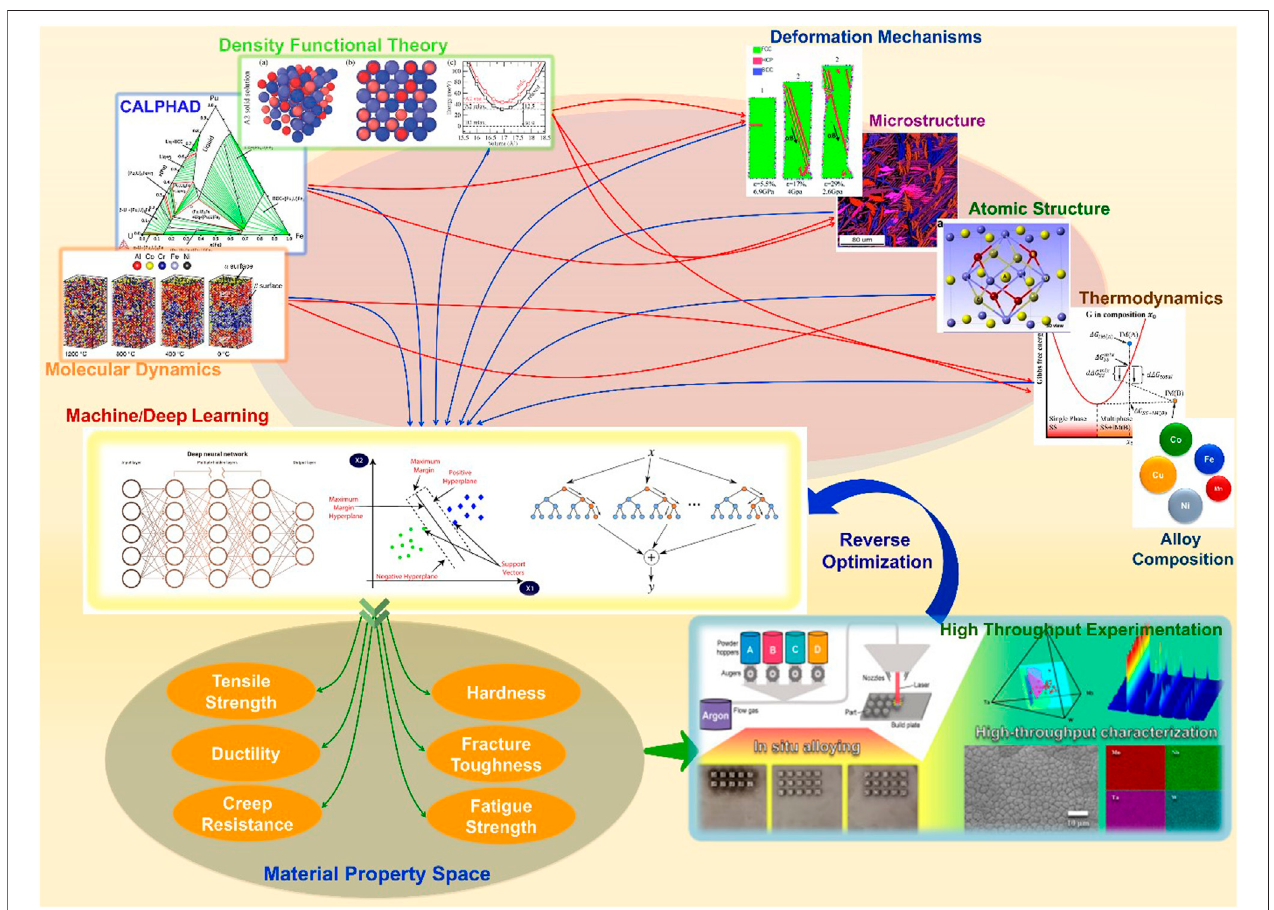
FIGURE 2 | Schematic diagram showing the simultaneous utilization of various high throughput computational alloy design tools to create a closed-loop property driven design strategy for HEAs.